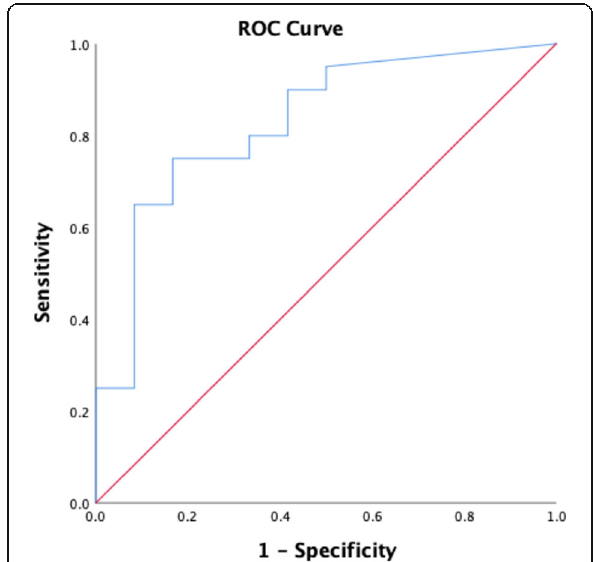
Fig. 5 Receiver operator curve of signal intensity in regions of fibrosis in CPFE patients compared to similar regions of the lungs in control subjects. The area under the curve was 0.82, p = 0.002. Using a SI value of ≥ 19 resulted in a sensitivity of 75% and a specificity of 86% in differentiating fibrosis in CPFE patients from dependent atelectasis in controls. CPFE , Combined pulmonary fibrosis and emphysema